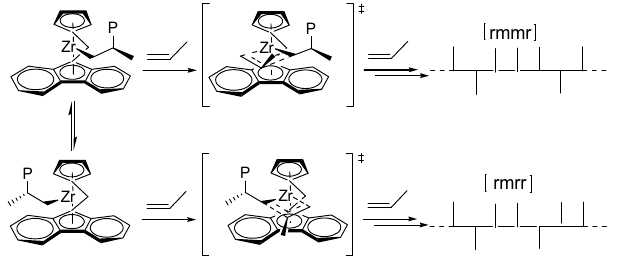
Figure 1. Errors in syndiotactic polypropene with C s -symmetric metallocenes: isolated stereoerrors (rmmr) by site control and (rmrr) by site epimerization.